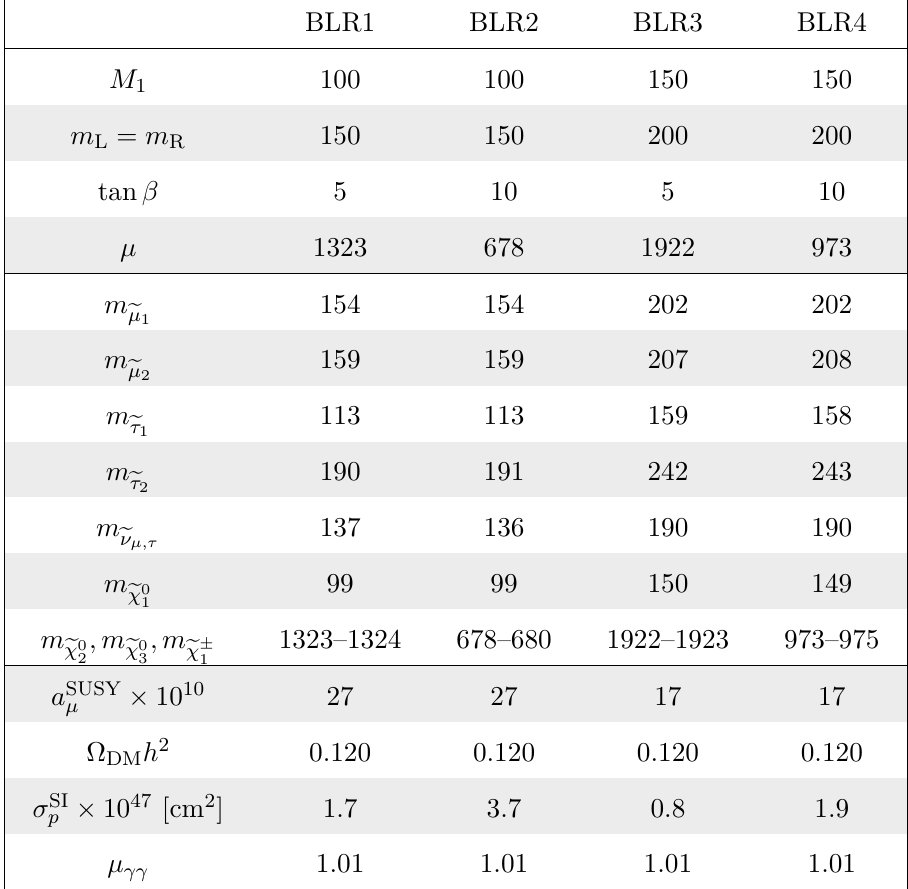
Table 2. Benchmark points for the pure-bino-contribution dominated scenario, where the universal slepton mass is used. The mass parameters are in units of